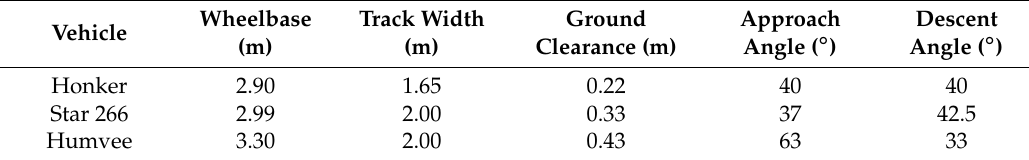
Table 3. Parameters of the analyzed vehicles [55–57].